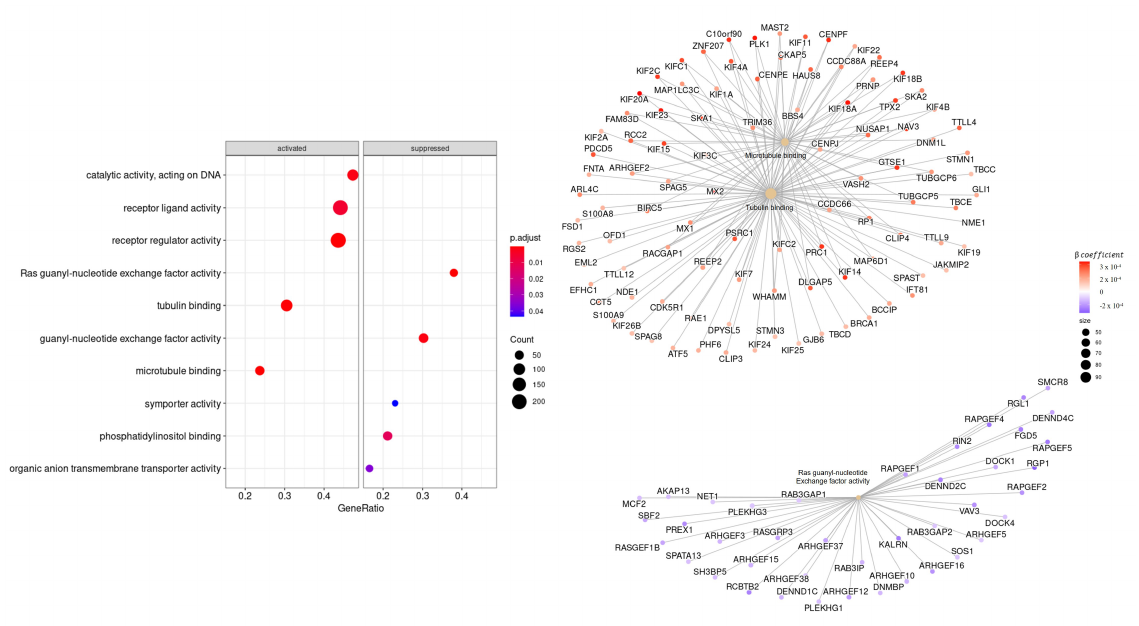
Figure 8. Gene ontology enrichment analysis regarding molecular function terms for a list of genes selected by EN ranked by the β coefficients of the regression. The left panel shows a dot chart with the most significant MF terms and on the right a gene-concept network plot of the three most enriched terms depicts the linkages of genes and biological concepts as a